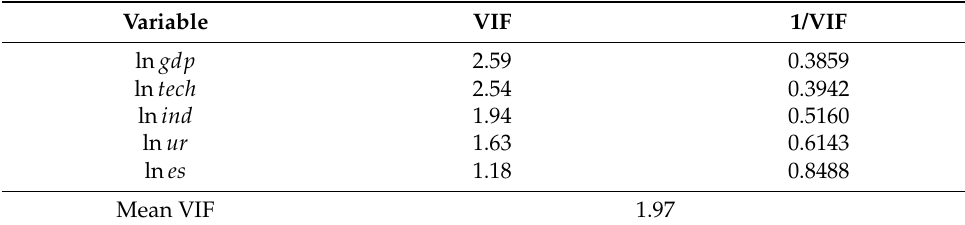
Table 4. Multicollinearity test.